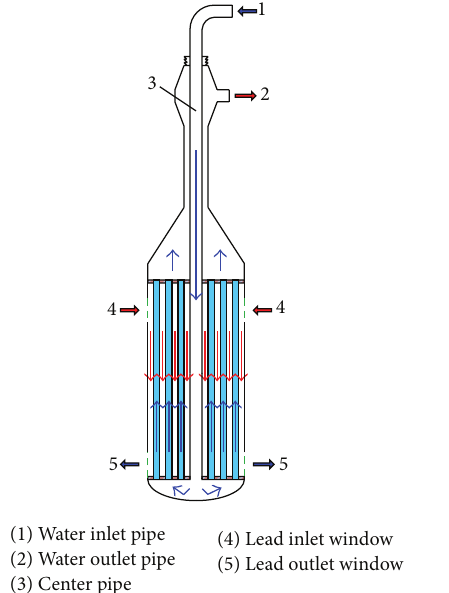
Figure 8: Conceptual design of primary heat exchanger.